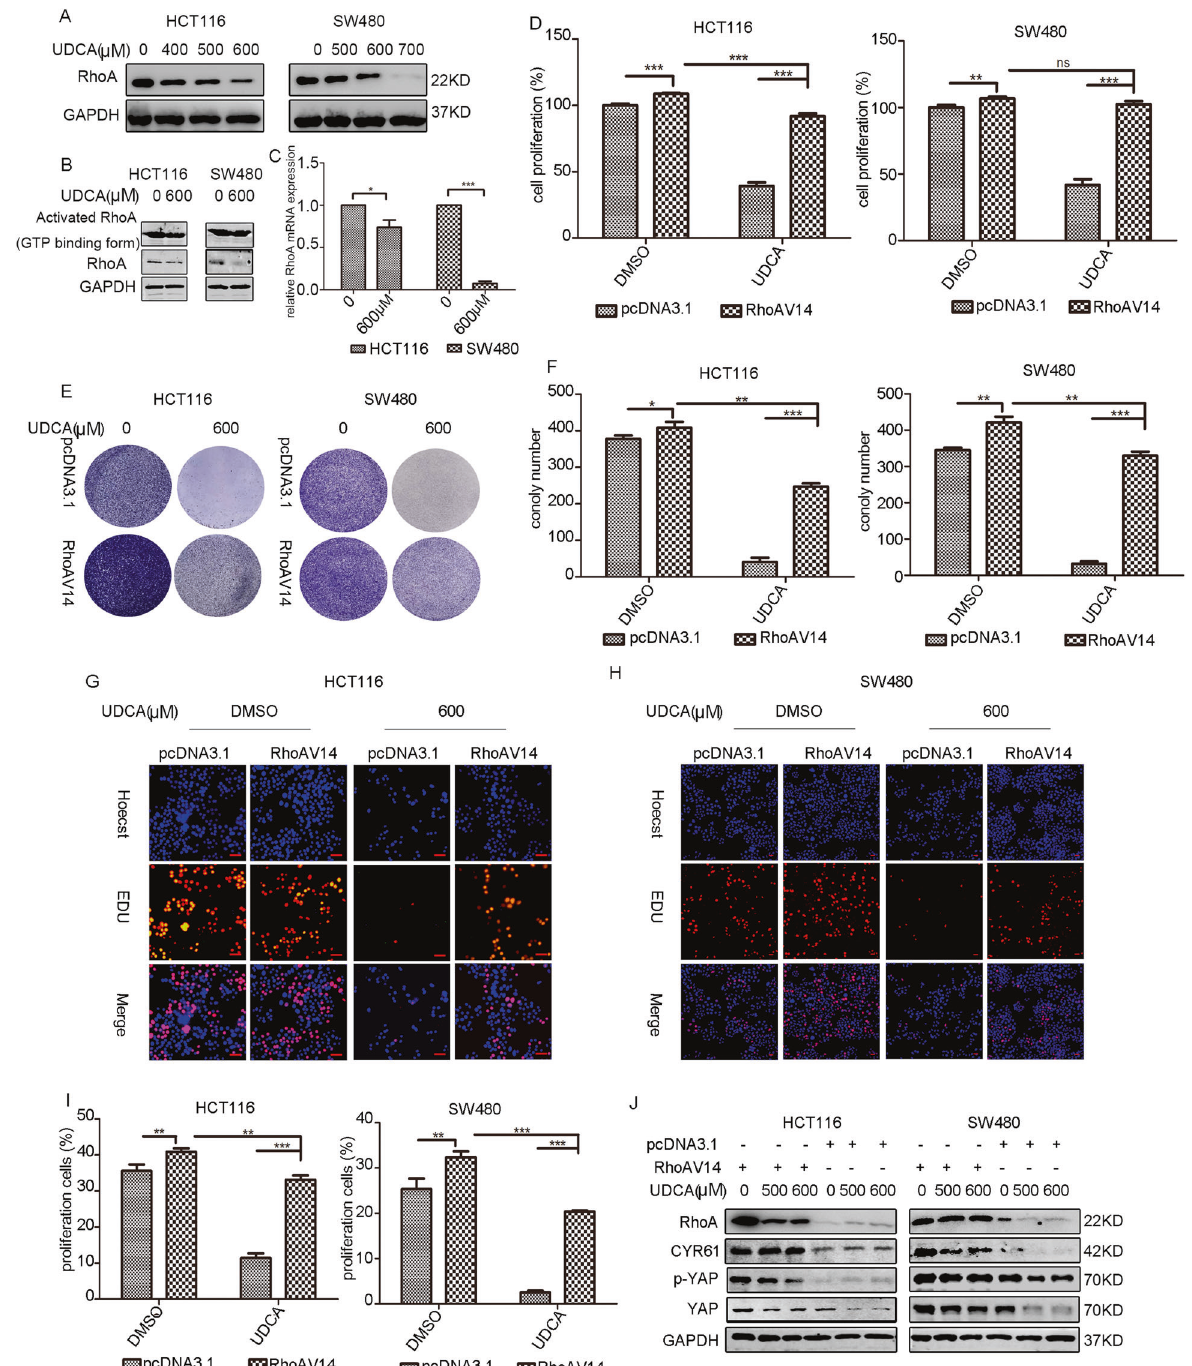
Fig. 3 UDCA inhibits Hippo pathway through the downregulation of RhoA expression. A WB for RhoA in HCT116 and SW480 cells treated with DMSO or UDCA (400 μ M, 500 μ M, and 600 μ M in HCT116 cells; 500 μ M, 600 μ M, and 700 μ M in SW480 cells) for 36 h. B Active RhoA detected by the RhoA pull down assay in HCT116 and SW480 cells treated with DMSO or 600 μ M UDCA for 36 h. C Quantitative real-time RT- PCR was used to measure the RhoA mRNA level in HCT116 and SW480 cells. GAPDH was used as a control, and *** p < 0.001 using Student ’ s t test (two-tailed). D MTT assay for HCT116 and SW480 cells cultured with pcDNA3.1 or RhoAV14 plasmid (or/and 600 μ M UDCA) for 3 days. Data are demonstrated as the mean ± SD, * p < 0.05, ** p < 0.01, and *** p < 0.001 with Student ’ s t test (two-tailed). E , F Clonogenic assays and qualitative analysis of the HCT116 and SW480 cells cultured with pcDNA3.1 or RhoAV14 plasmid (or/and 600 μ M UDCA) at day 7. EdU incorporation assay was performed to further test the cell proliferation at 72 h post-transfection in HCT116 cells ( G ) and SW480 cells ( H ). Scale bar: 25 μ m. Red labeled cells indicated as the proliferated cells. I The percentage of the proliferated HCT116 cells and SW480 cells. Data are demonstrated as the mean ± SD, * p < 0.05, ** p < 0.01, and *** p < 0.001 with Student ’ s t test (two-tailed). J WB for RhoA, YAP, p-YAP, and CYR61 in HCT116 and SW480 cells cultured with pcDNA3.1 or RhoAV14 plasmid (or/and 500 μ M and 600 μ M UDCA).